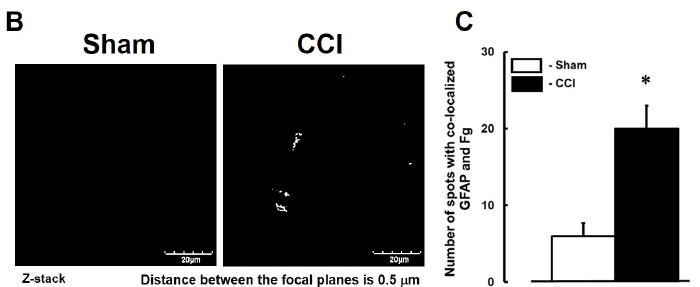
Figure 2. Deposition of fibrinogen (Fg) in vasculo ‐ astrocyte interface after cortical contusion injury (CCI) in mice. ( A ) Examples of astrocytes and their endfeet surrounding vessels and Fg (red) deposited in the extravascular space 14 days after sham ‐ operation (sham) and CCI. Astrocytes are identified by expression of glial fibrillary acidic protein (GFAP, green) and vascular endothelium is defined by Lycopersicon Esculentum agglutinin tomato lectin (LEA, blue). Images of each area of interest were collected by acquiring at least 4 focal planes with increment of 0.5 μ m to form a final z ‐ stack image. The highlighted areas were enlarged 3 ‐ times (side images). Short white arrows point to Fg and astrocyte endfeet co ‐ localization (shown in yellow). Placing the Image Pro ‐ plus software’s line profile probes (horizontal and vertical yellow lines) on enlarged images, we obtained fluorescence intensity profiles along the X (panels are shown at the bottom of the respective enlarged images) and Y (panels are shown on the sides of the respective enlarged images) axis. Fluorescence intensity profiles show that at the area of co ‐ localizations (shown in yellow), Fg (red) was located between the vessels (blue) and astrocyte endfeet (green). In the right horizontal panel, thin and long white arrows pointing to a vessel (blue), Fg (red), and astrocyte labeled with GFP (green) in the same vertical plane clearly show Fg between the vessel and astrocyte; ( B ) Shown are examples of z ‐ stack images of spot co ‐ localization after deconvolution of original images of brain samples from mice with sham ‐ operation) or with CCI); ( C ) Average number of co ‐ localized Fg and GFAP spots calculated after deconvolution of experimental stack images are presented for each experimental group. * p < 0.05 vs. Sham. n = 4.